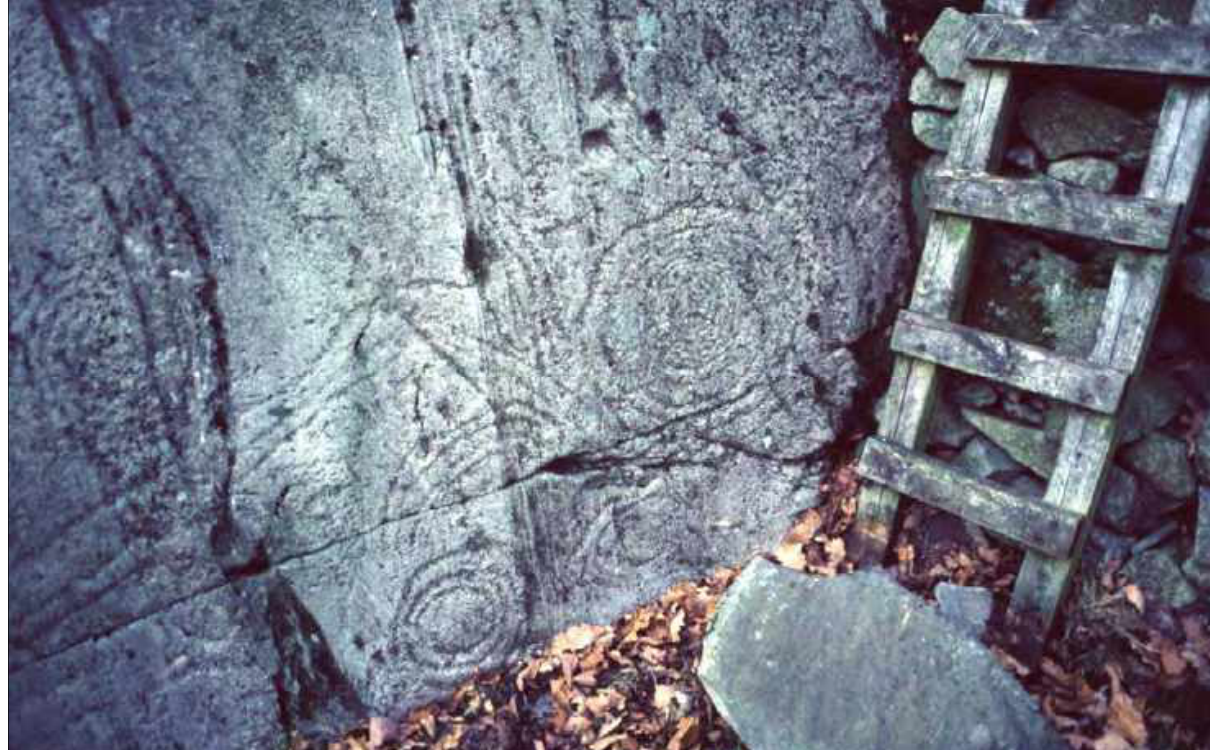
Fig 2.21 Prehistoric rock art at Copt Howe, Langdale, Cumbria (John